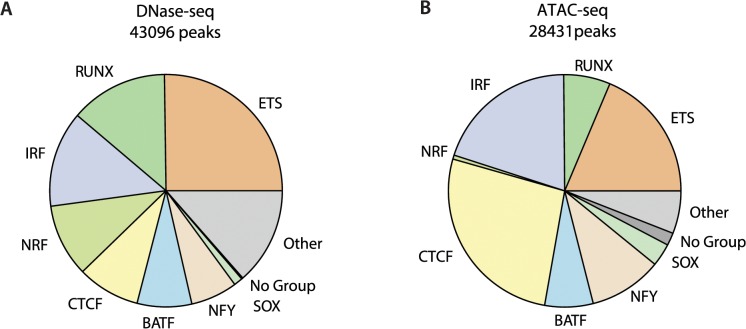
SeqGL identifies sequence signals underlying ATAC-seq peaks.Distribution of top-scoring TFs across (A) DNase-seq and (B) ATAC-seq peaks. TFs identified by SeqGL using ATAC-seq peaks are IRF, BATF and other cell-type factors that are strongly represented across peaks in both data types whereas NRF and CTCF show enrichment in DNase-seq and ATAC-seq respectively. The fraction of intergenic enhancer peaks is significantly higher in ATAC-seq, potentially explaining the higher occurrence of CTCF.